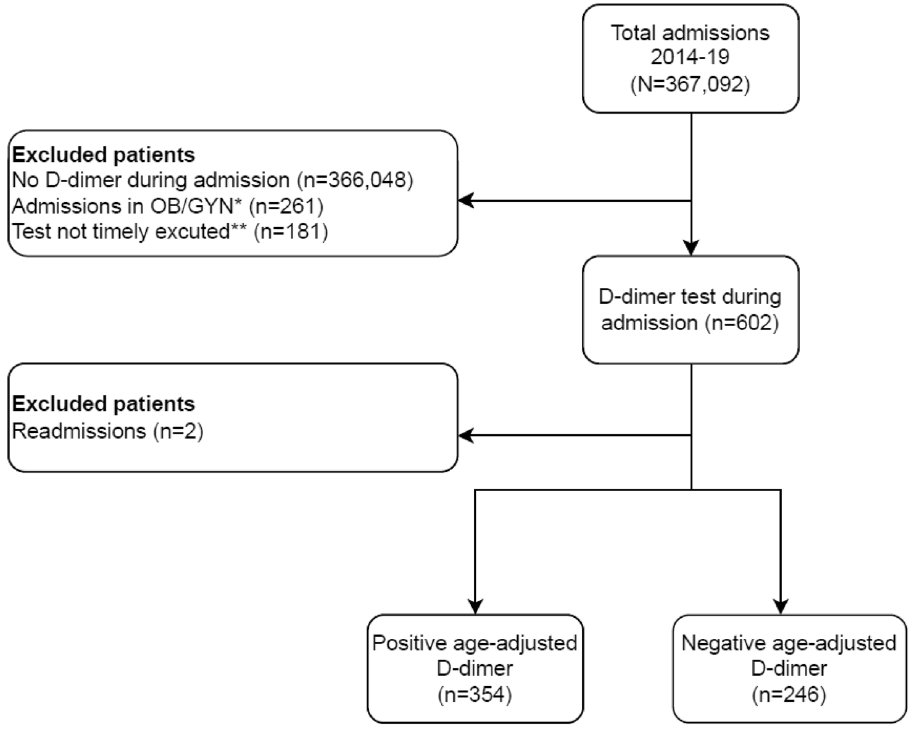
Figure 1. Flow diagram of the study cohort. * OB/GYN obstetrics and gynecology admissions during pregnancy and post-partum period. **D-dimer test drawn before admission or after definitive imaging